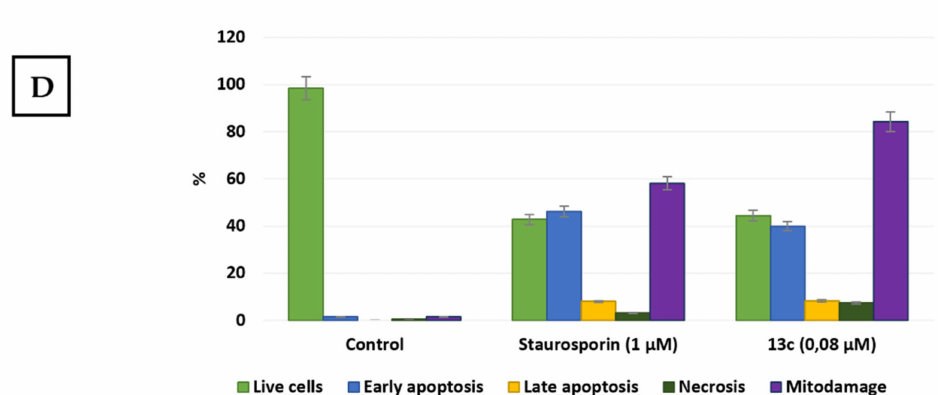
Figure 7. Changes in the mitochondrial potential ( ∆Ψ ) and related early and late apoptosis in Jurkat cells induced by compound 13c . ( A ) Control sample containing live cells; ( B ) Staurosporine (1 µ M); ( C ) 13c (0.08 µ M); ( D ) Histogram showing the percentage of damaged mitochondria and phases of apoptosis. The cells were stained by MitoSense Red, Anexin V, CF488A and 7-AAD. The incubation time was 4 h. Results are expressed as mean ± SE ( n =